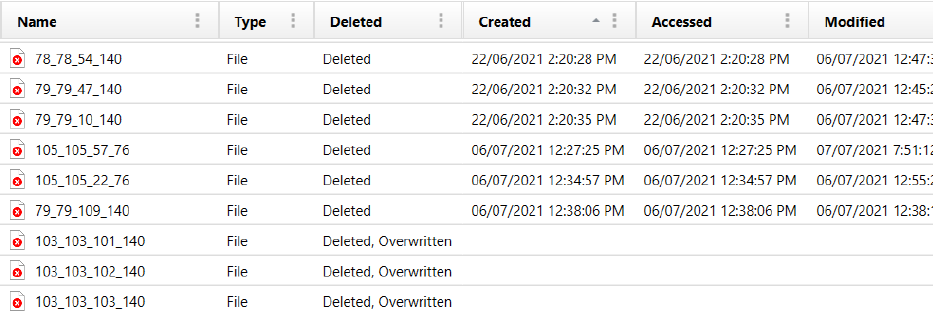
Figure 11. Potential deleted and overwritten utterance clips from Tone Analysis sessions along with MAC times, as shown on Magnet AXIOM